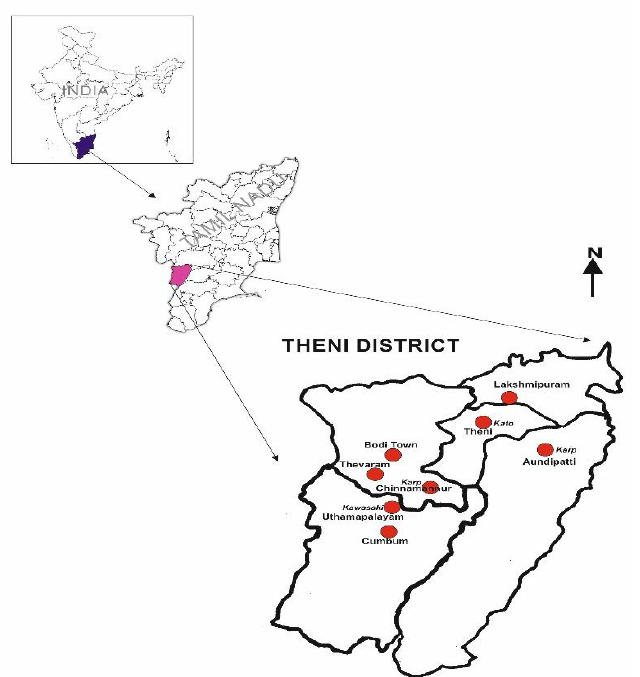
Figure 1. Location of the study area and O. tsutsugmushi genotype detected in this study in Theni district, Tamil Nadu. district, Tamil